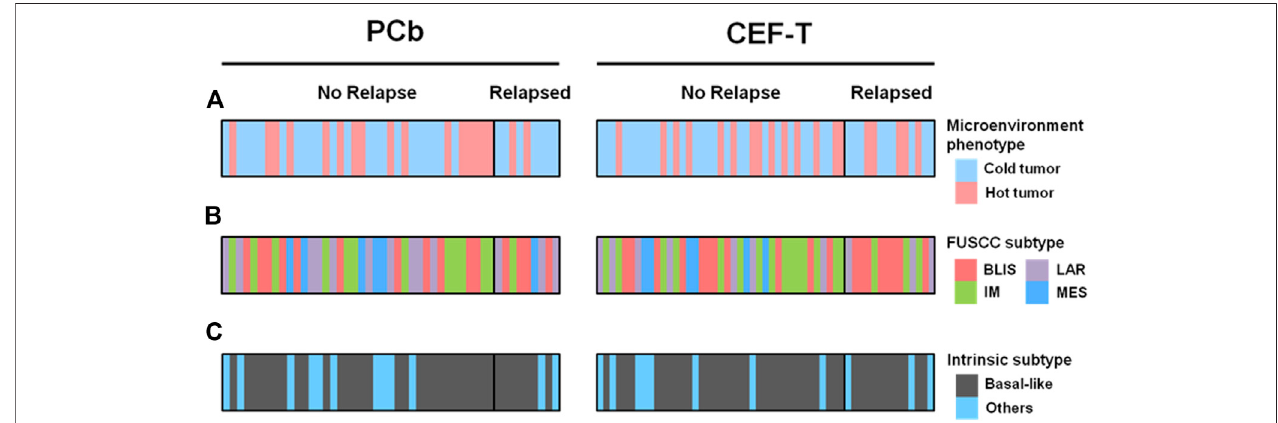
FIGURE 1 | Microenvironment phenotype and other different subtypes by treatment cohorts. (A) Microenvironment phenotype, (B) FUSCC subtype, and (C) intrinsic subtype of the patients enrolled in the analysis. BLIS indicates basal-like and immune-suppressed; CEF-T, fl uorouracil, epirubicin, and cyclophosphamide